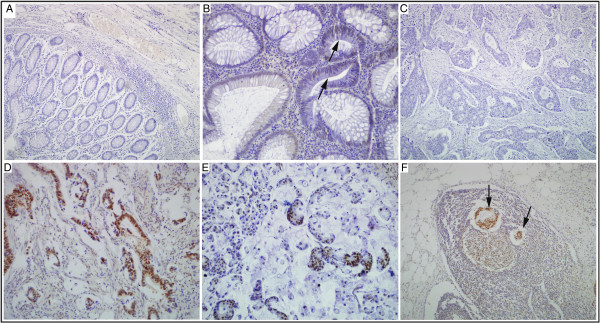
Immunohistochemical staining of DEK protein in colorectal cancer, adenoma, and normal mucosa. (A) DEK is absolutely negative for DEK protein in normal colorectal mucosa (Original magnification, ×100). (B) DEK is positive in the dysplastic cells of colorectal adenomas (Original magnification, ×200). (C) DEK is negative in colorectal cancer without lymph node metastasis (Original magnification, ×200). (D) DEK is strongly positive in the cancer cells of colorectal cancer with lymph node metastasis (Original magnification, ×200). (E) DEK is positive in the signet ring cells of colorectal cancers. (F) DEK is strongly positive in the metastatic cancer cells (arrows) in lymph node (Original magnification, ×100).